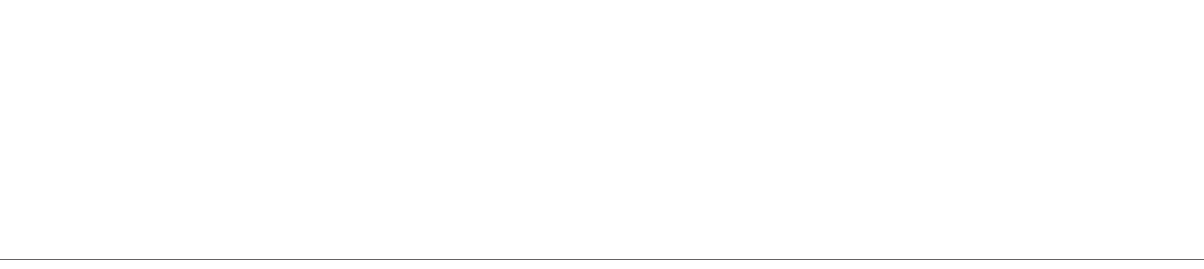
Frontiers in Neuroscience | www.frontiersin.org